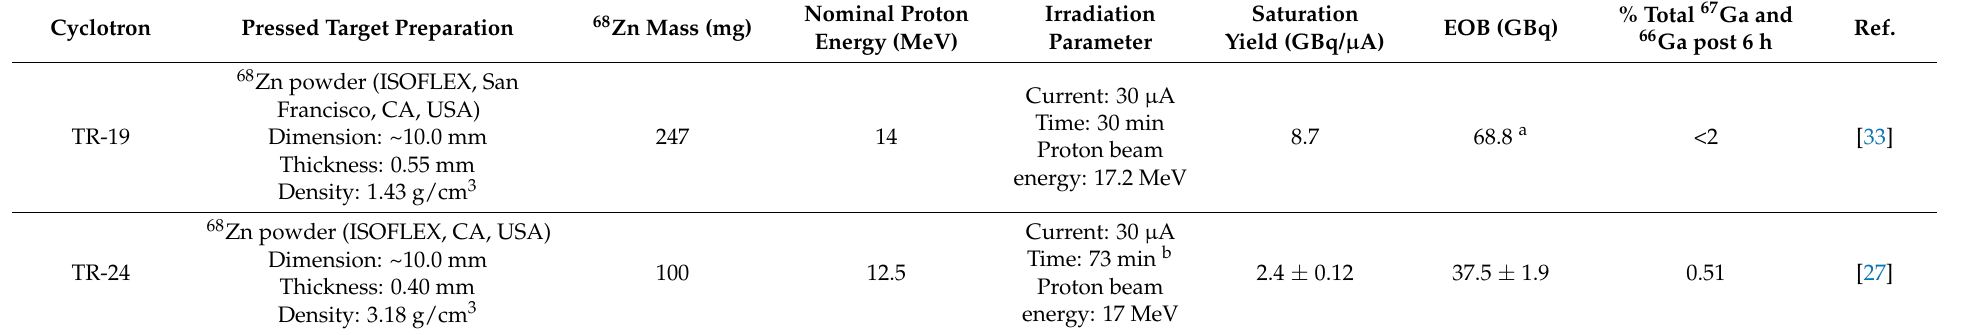
Table 2. 68 Ga production using solid target on an Advanced Cyclotron Systems, Inc. (ACSI) Cyclotrons. Cyclotron